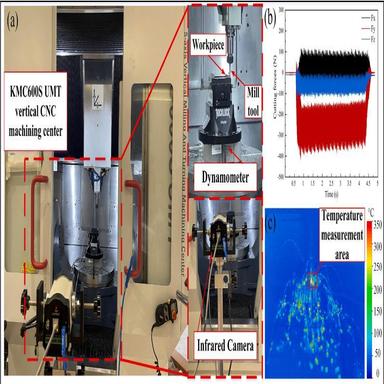
Experimental setup and cutting data processing.